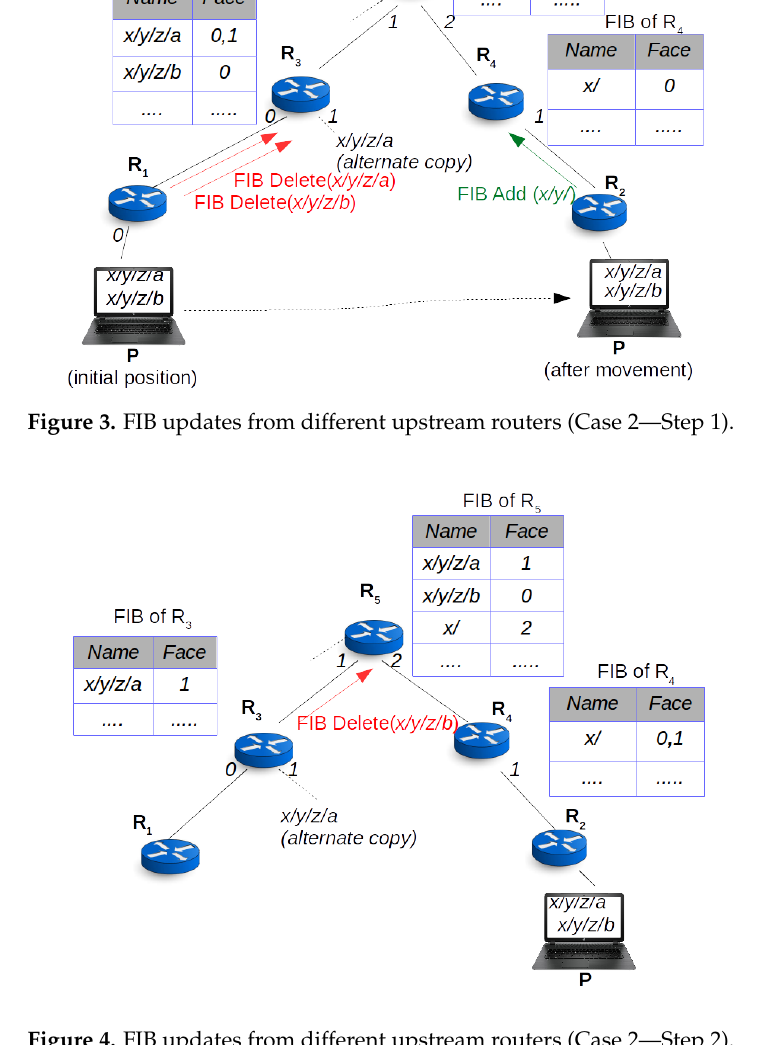
Figure 4. FIB updates from different upstream routers (Case 2—Step